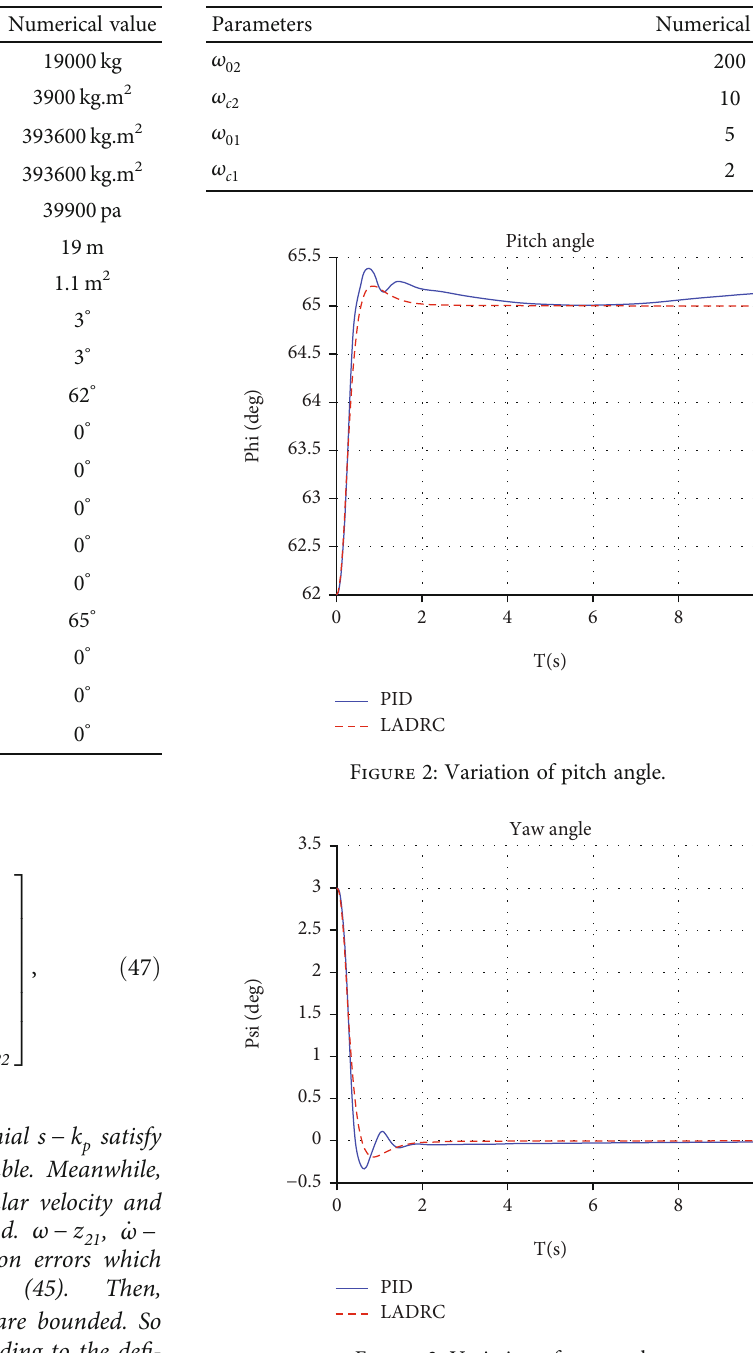
Figure 3: Variation of yaw